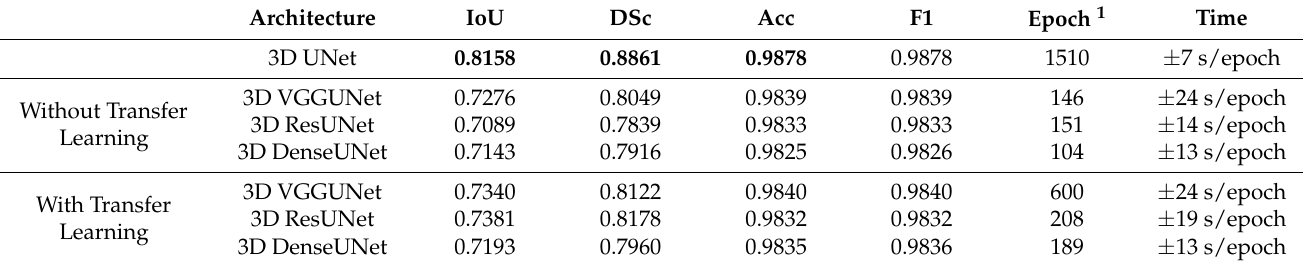
Table 7. The IoU Score, Dice Score, accuracy, and F1-score, epoch of learning, and time per epoch results of each architecture for the CT-scan multi-class segmentation.